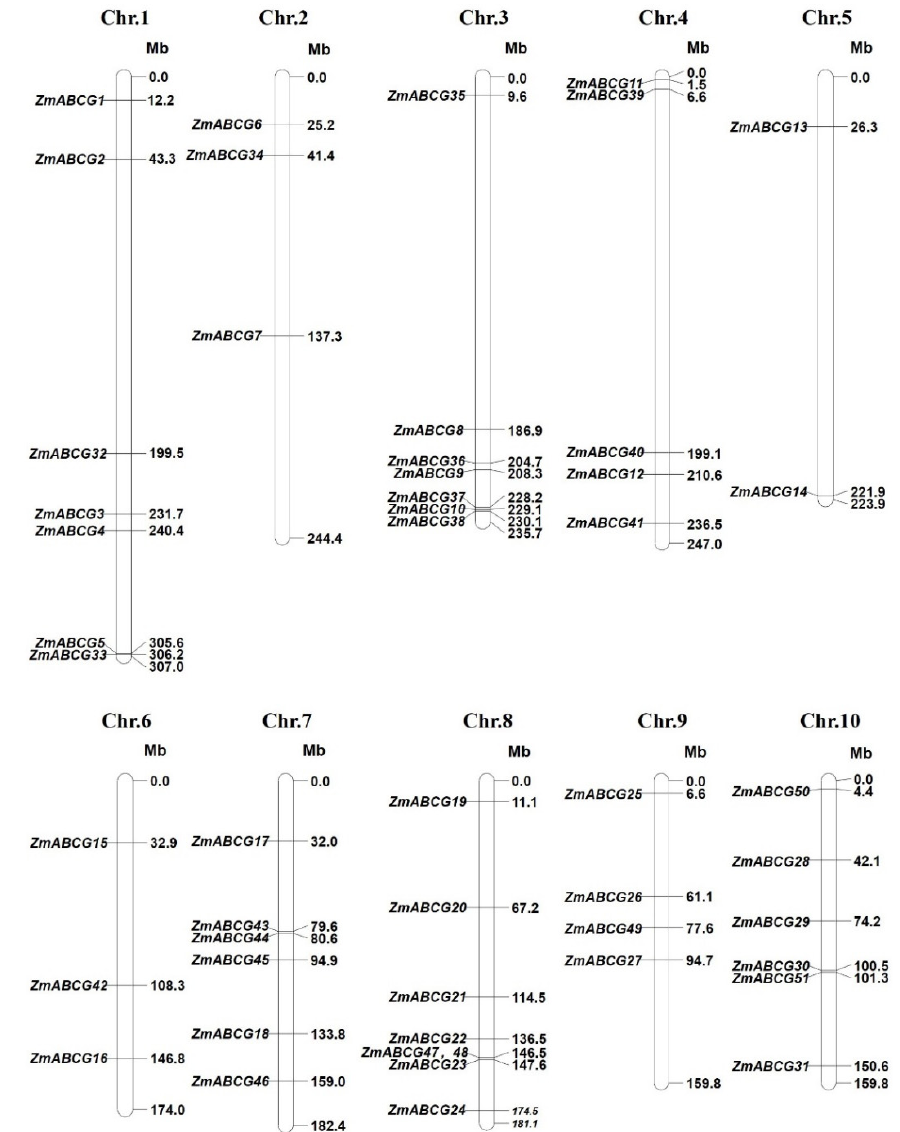
Figure 1. Genomic distribution of the 51 ZmABCG genes in maize chromosomes. Chromosome number and genomic length are indicated at the top and bottom of each chromosome, respectively. The physical location of each ZmABCG gene is indicated to the right of chromosomes. Mb, million base pair.